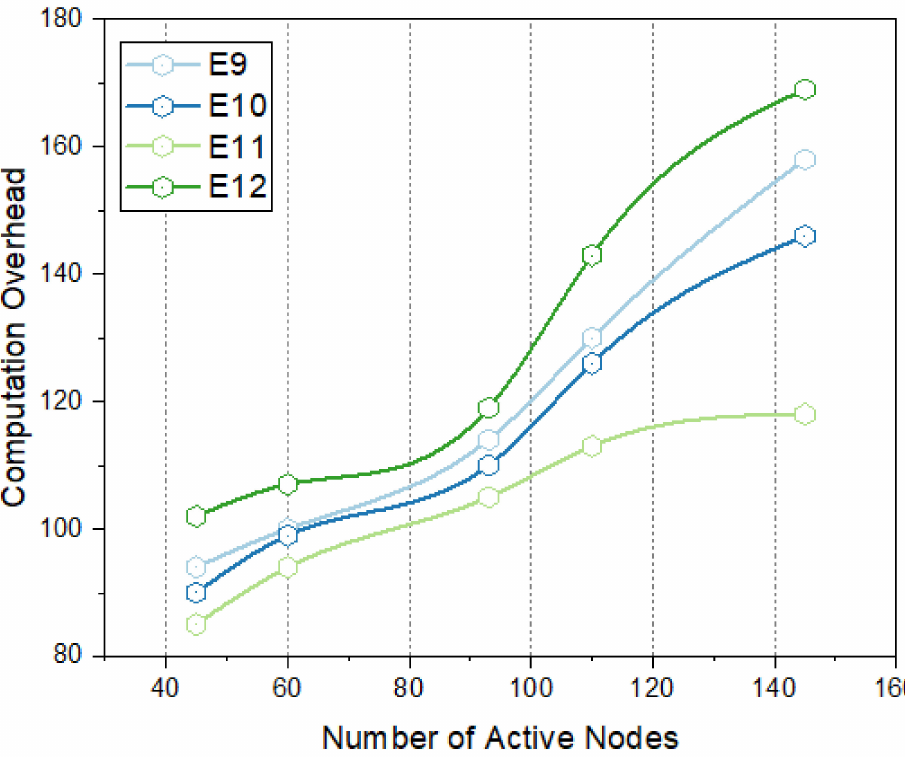
Figure 17. Energy-efficient routing schemes and Overhead.